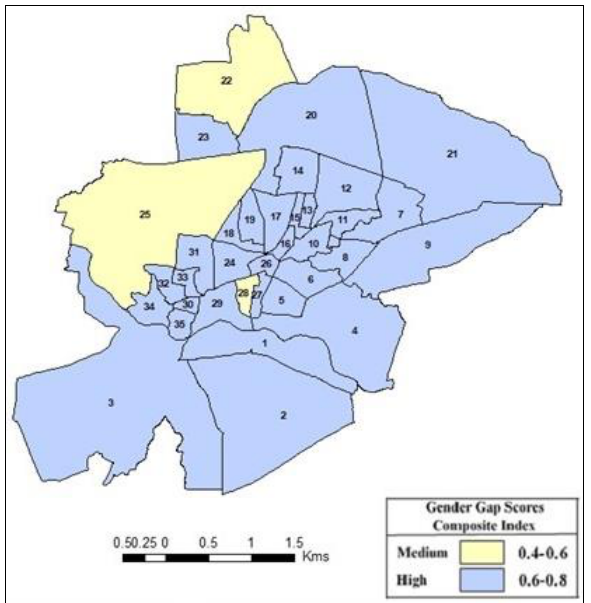
Fig. 6. Sehore M.C. Scores on the Overall Gender Gap Index,